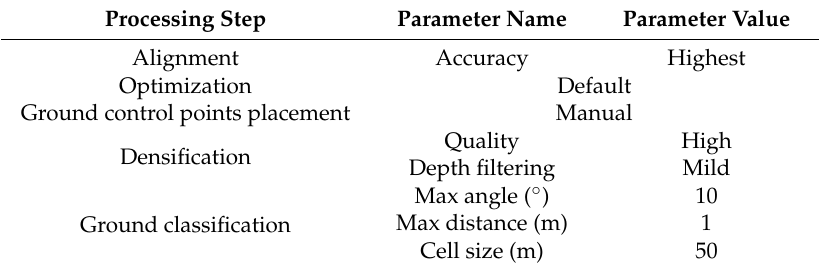
Table 3. Summary of the most relevant parameters adopted in the photogrammetric processing. The parameters were for Agisoft Photoscan. Further parameters are available in the software but here we report only the most relevant ones and those that were modified from default settings for this particular